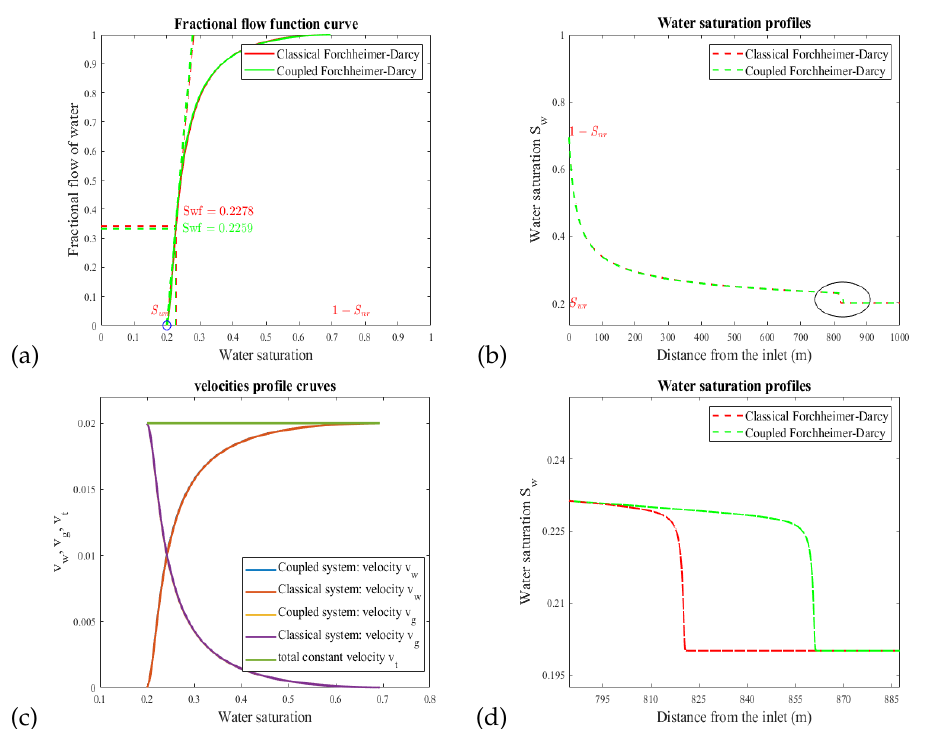
Figure 5. One-dimensional linear: ( a ) water fractional flow f w ; ( b , d ) water saturation S w at front; and ( c ) water velocity v w , gas velocity v g , the total constant velocity v t ; and water-phase pressure and gas-phase pressure after 1000